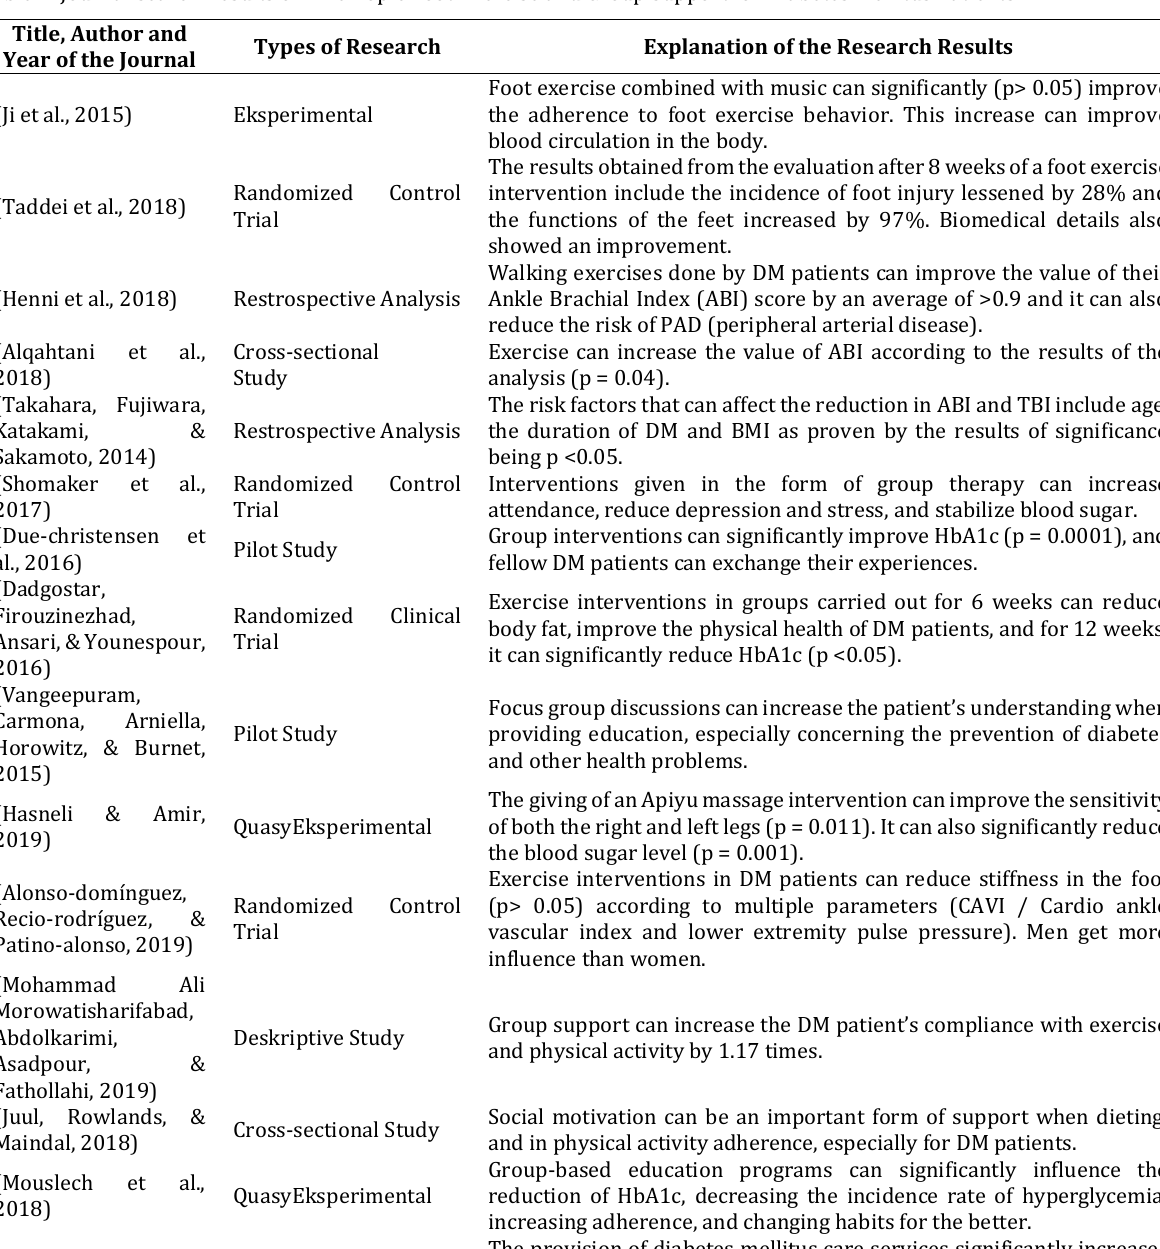
Table 1. Journal Search Results on The Topic Foot Exercise and Group Support for Diabetes Mellitus